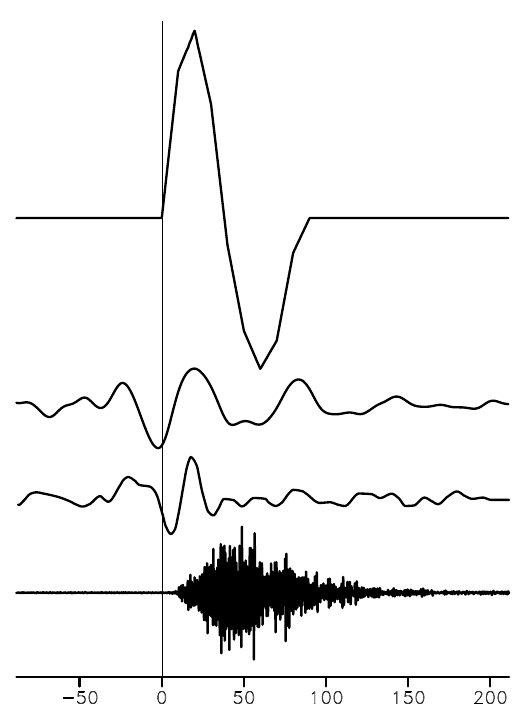
Figure A1. curve shows the N–S force history as determined in our analysis (cf. Fig. 4). Second curve from the top shows the output from our simulation of the effect of the method used by Iverson et al. (2015) on the recovery of the N–S force history. The third curve from the top shows the N–S force as determined in Iverson et al. (2015). The top three curves are plotted with the same vertical scale, and on the same time axis, with 0 corresponding to 17:37:10.5 (UT). The bottom trace shows the short period seismogram recorded at the closest station JCW, shifted earlier by 6.4s to account for the propagation delay to the